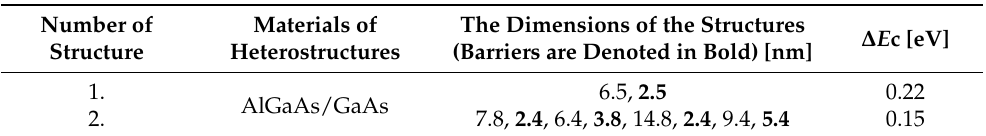
Table 1. Basic parameters of simulated superlattice structures; structure 1 is presented in [28], and structure 2 reported in [26].